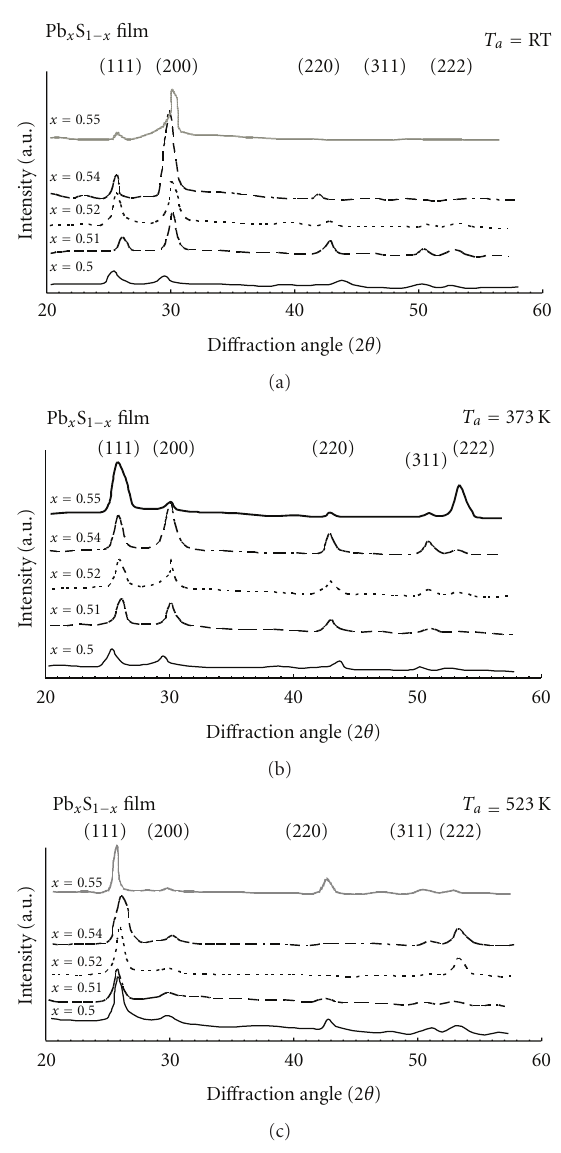
Figure 2: X-ray di ff raction pattern for Pb x S 1 − x films at various x content and (a) unannealed (RT) (b) T a = 373K (c) T a =